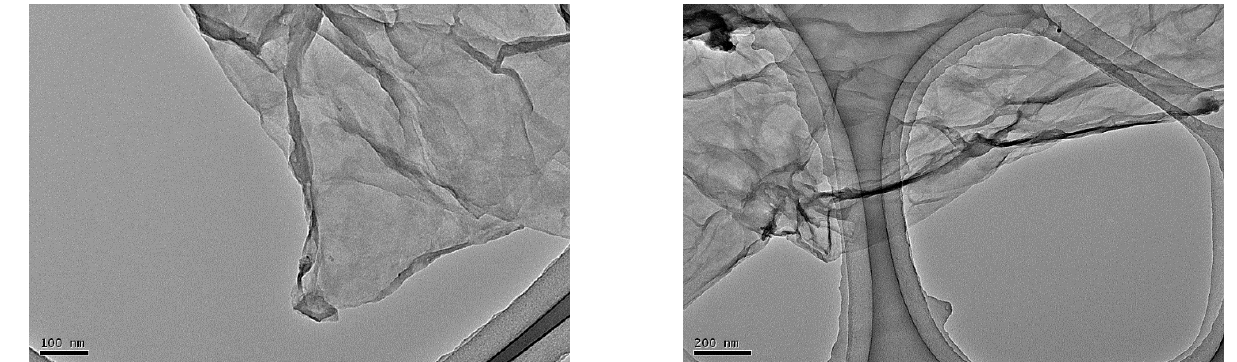
Figure 7. TEM images of rGO synthesized using lemon juice.